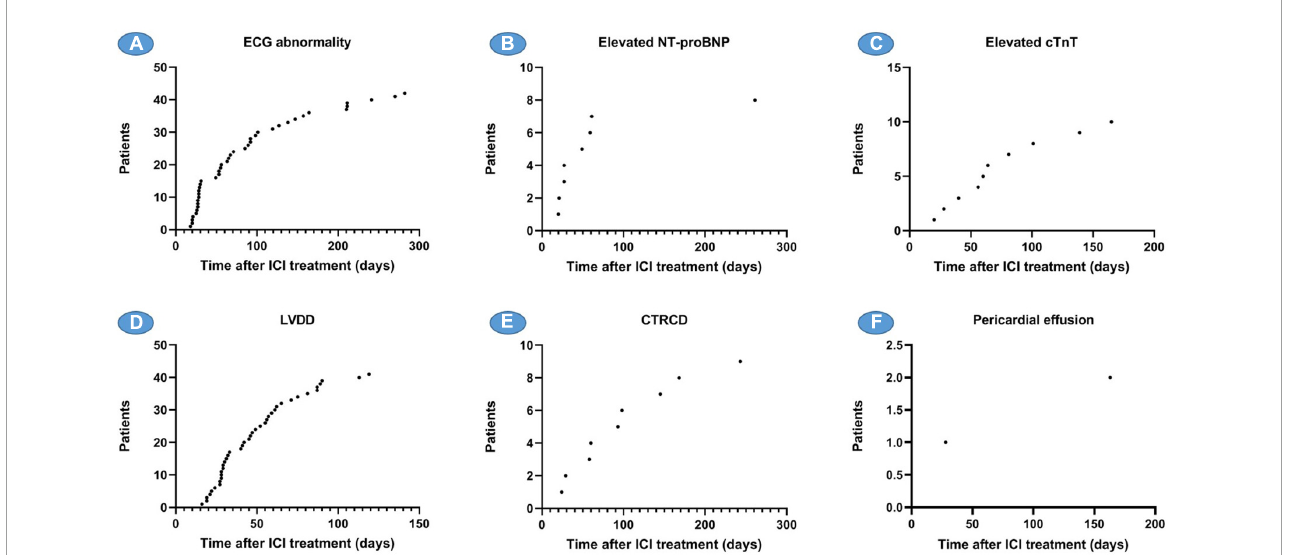
FIGURE5 Time of onset of various ACEs since receiving ICI. (A) The number of patients with ECG abnormalities and the time of onset, (B) the number of patients with elevated NT-proBNP and the time of onset, (C) the number of patients with elevated cTnT and the time of onset, (D) the number of patients with LVDD and the time of onset, (E) the number of patients with CTRCD and the time of onset, and (F) the number of patients with pericardial effusion and the time of onset. ACEs, adverse cardiovascular events; NT-proBNP, N-terminal pro brain natriuretic peptide; cTnT, cardiac troponin T; LVDD, LV diastolic dysfunction; CTRCD, cancer therapy-related cardiac